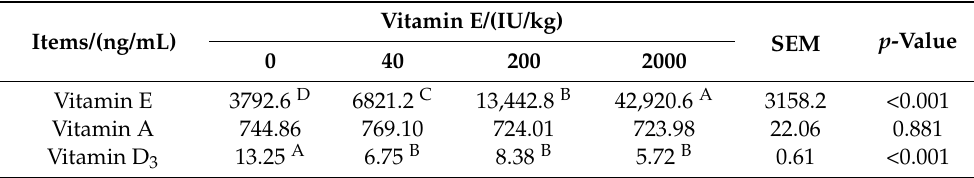
Table 6. Effects of dietary vitamin E supplementation on plasma concentration of vitamin E, A, and D 3 in breeding geese 1